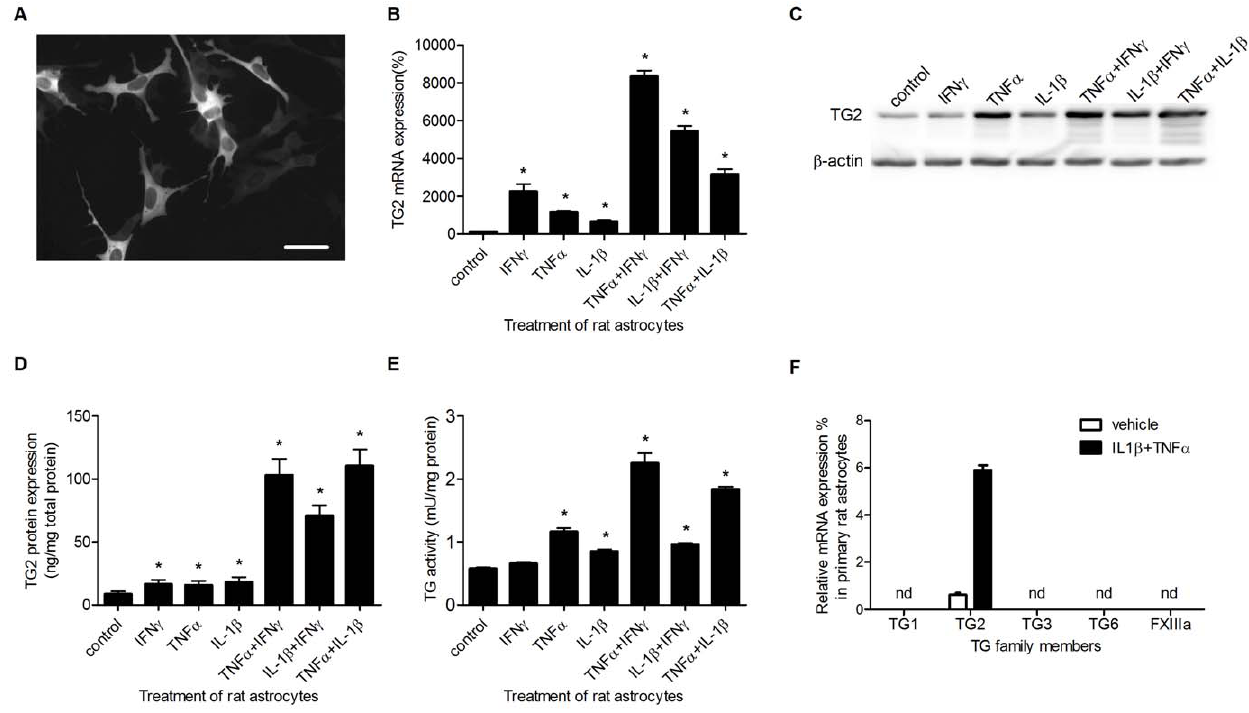
Figure 1. TG2 expression in primary rat astrocytes. A ) TG2 is expressed in primary rat astrocytes as visualized by immunocytochemical analysis. Scale bar: 50 m m. B ) TG2 mRNA expression after treatment with various single cytokines or with cytokine combinations. C ) TG2 protein expression visualized by western-blot and D ) measured with ELISA. E ) TG2 activity levels measured with the TG Covtest TCMA. F ) mRNA levels of transglutaminase (TG) family members in primary rat astrocytes. Data are expressed as mean + s.e.m., n=6 per condition (F: n=3 per condition), *P , 0.05 compared to control, nd=not detectable.